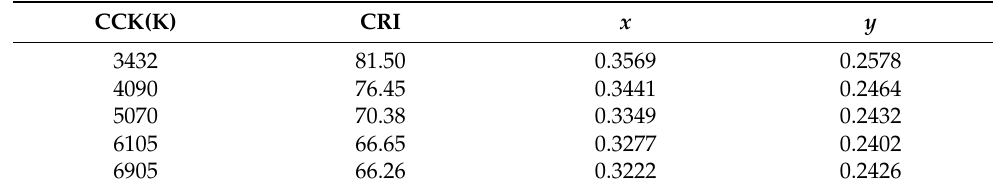
Figure 5. ( a ) Variation curves of CCT VS voltage of ITO glass. ( b ) LED light color under different voltages of ITO glass. ( c ) Chromaticity diagram at different voltages of ITO glass. Table 1. The values of correlated color temperature (CCT), color rendering index (CRI), Commission Internationale de l’Eclairage (CIE) coordinates.